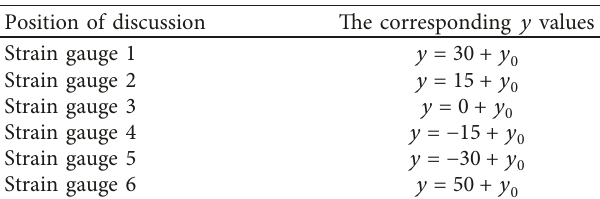
Figure 9: Relationship between the offset of bending neutral layer and time. Table 5: The distance from the stress location to the bending neutral layer.